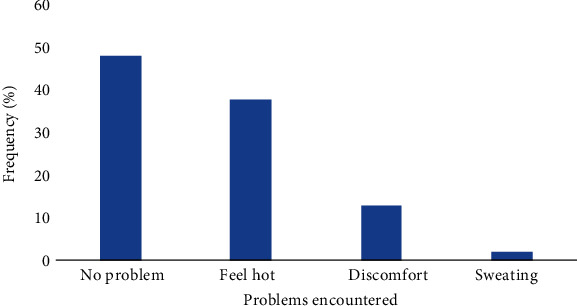
Problem encountered during the use ITNs.